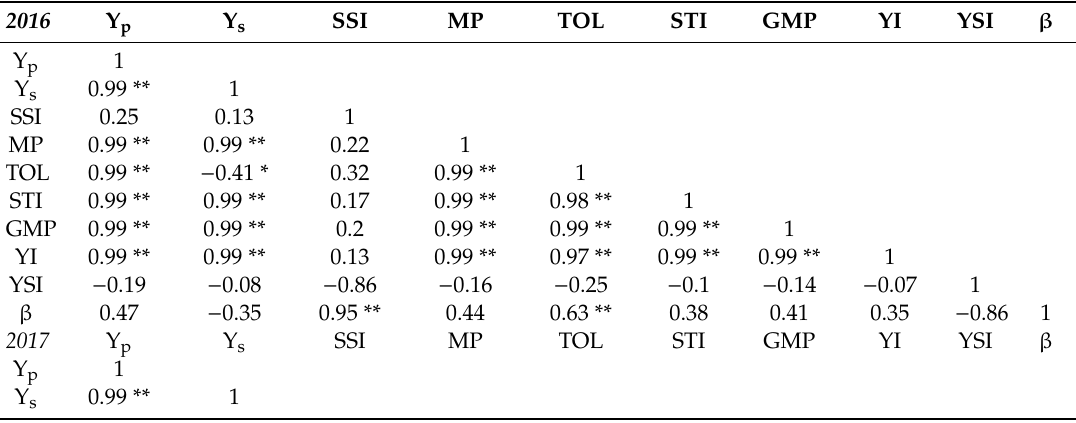
Table 6. Simple correlation coe ffi cients between Y p , Y s , and drought tolerance / susceptibility indices of genotypes in Bardsir in three